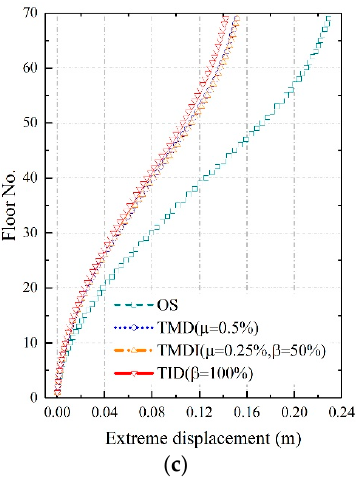
Figure 14. Profile of extreme wind-induced displacement response at the x -axis along the building height corresponding to three different wind directions: ( a ) 0° wind direction. ( b ) 45° wind direction. ( c ) 90° wind direction.